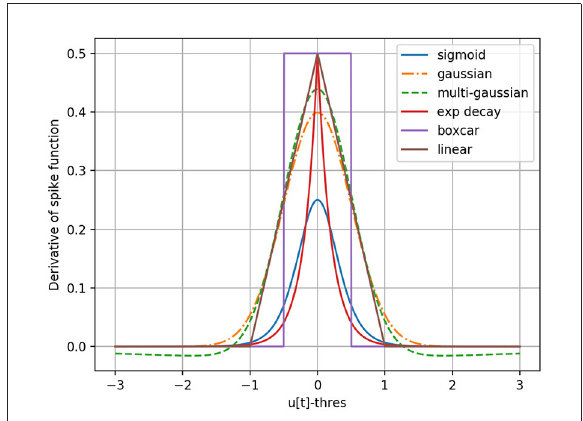
FIGURE1 Different surrogate gradient functions to approximate the derivative of the step-function responsible for spike